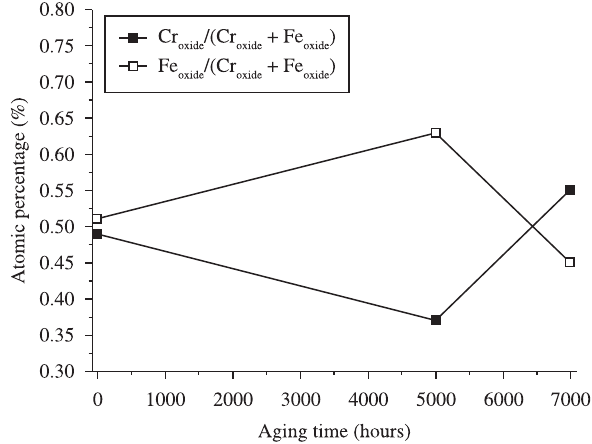
Figure 8. Composition of the oxide layer analyzed by XPS of duplex stainless steel alloy aged at 300